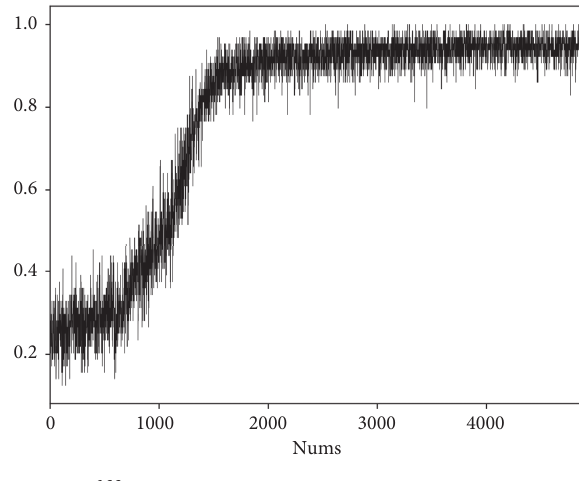
Figure 13: Change of accuracy rate during LSTM model